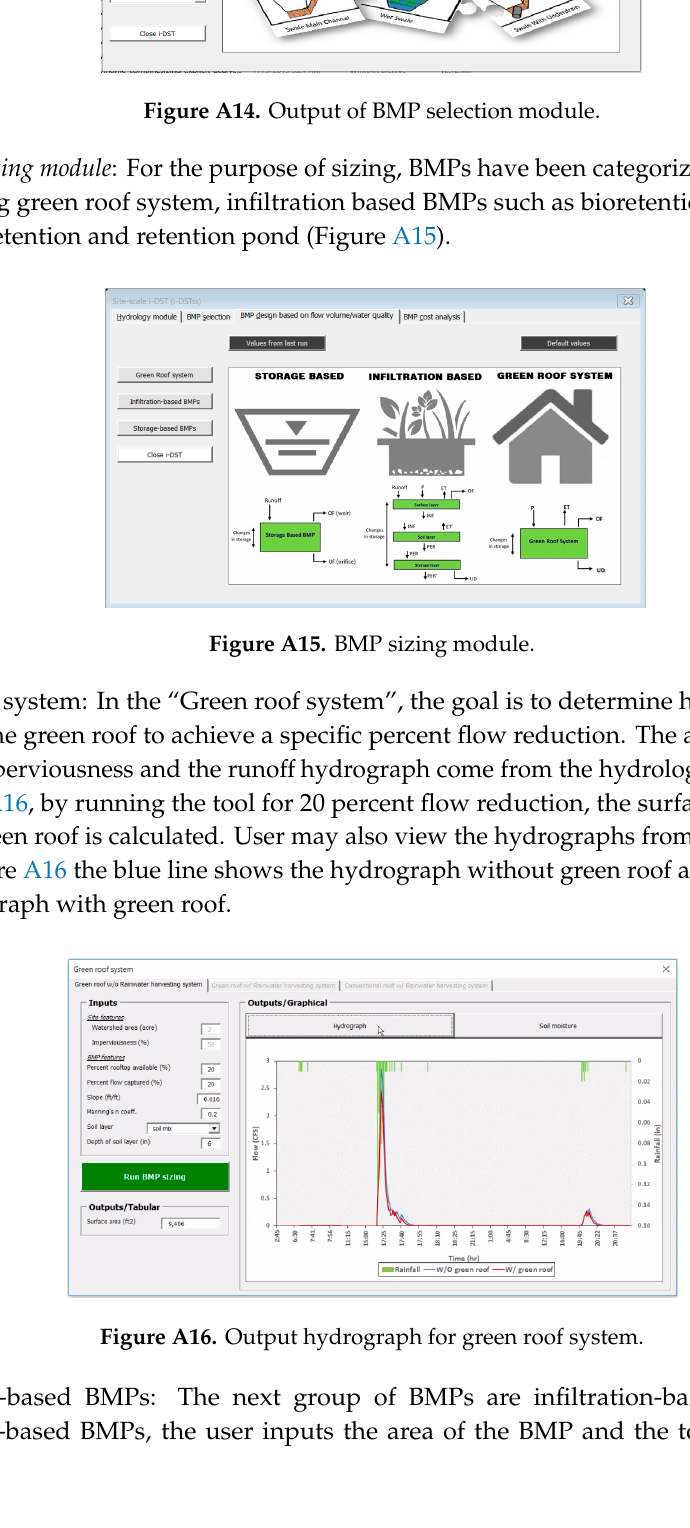
Figure A17. Output hydrograph for infiltration-based BMPs The tool als. Figure A18. Water level tracking in infiltration-based BMPs